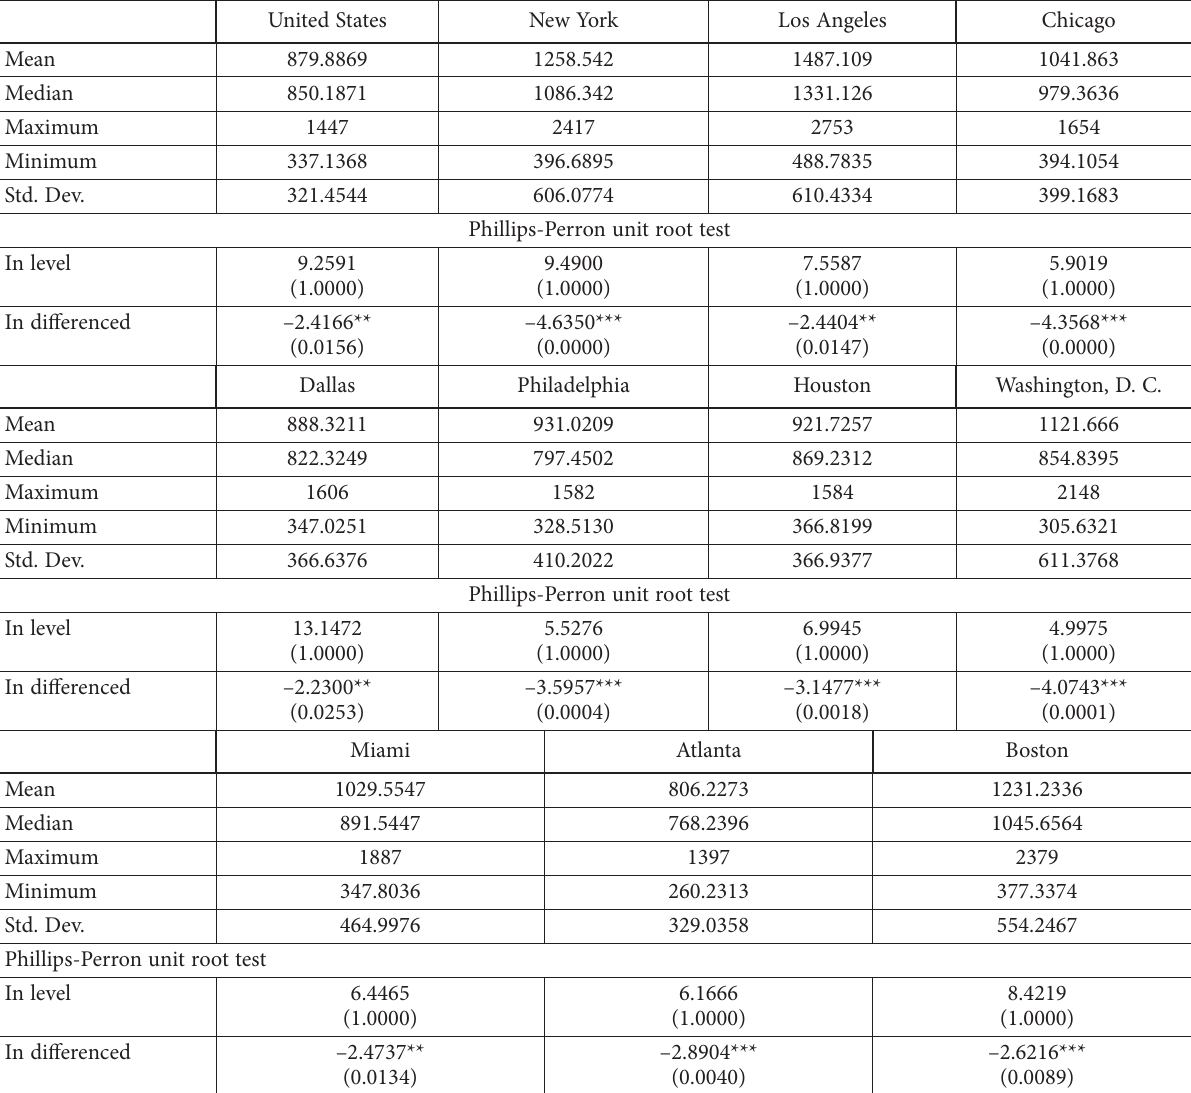
Table 2. The simple statistical and unit root test of rental